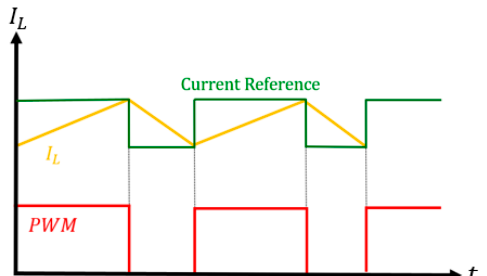
Figure 20. Experimental setup with boost converter.